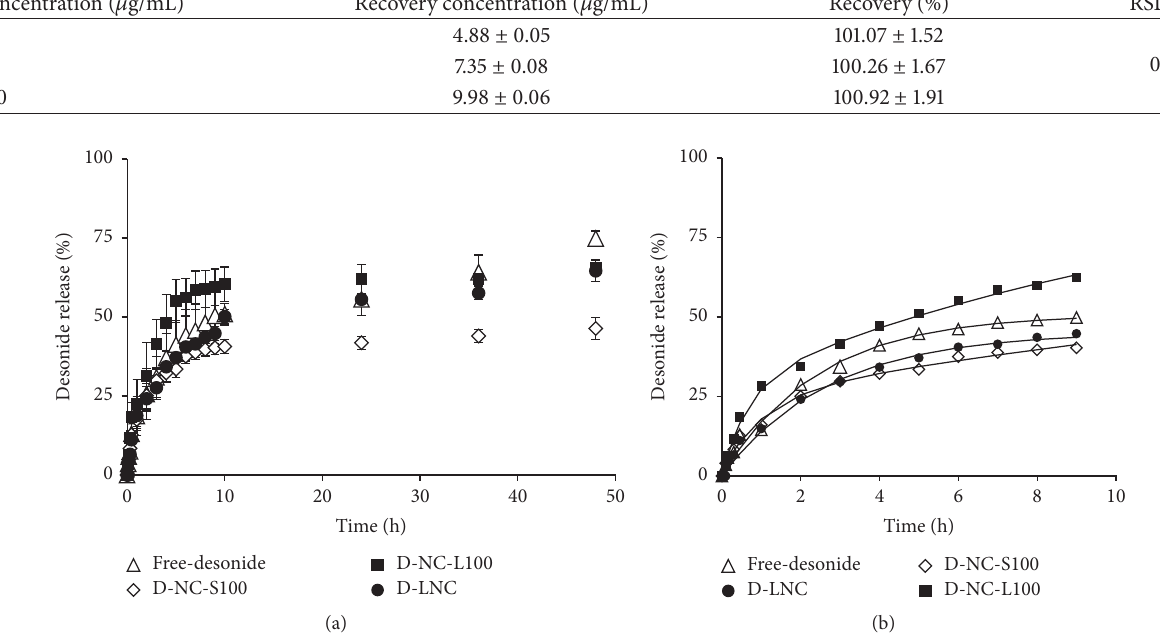
Figure 2: (a) Release profile of D-NC-S100, D-NC-L100, D-LNC, and free-desonide using dialysis sac. Statistical significance (Tukey, 𝑝 < 0.05 ). (b) The lines correspond to the fitting to the monoexponential equation for D-LNC and free-desonide, biexponential equation for D-NC-L100 and